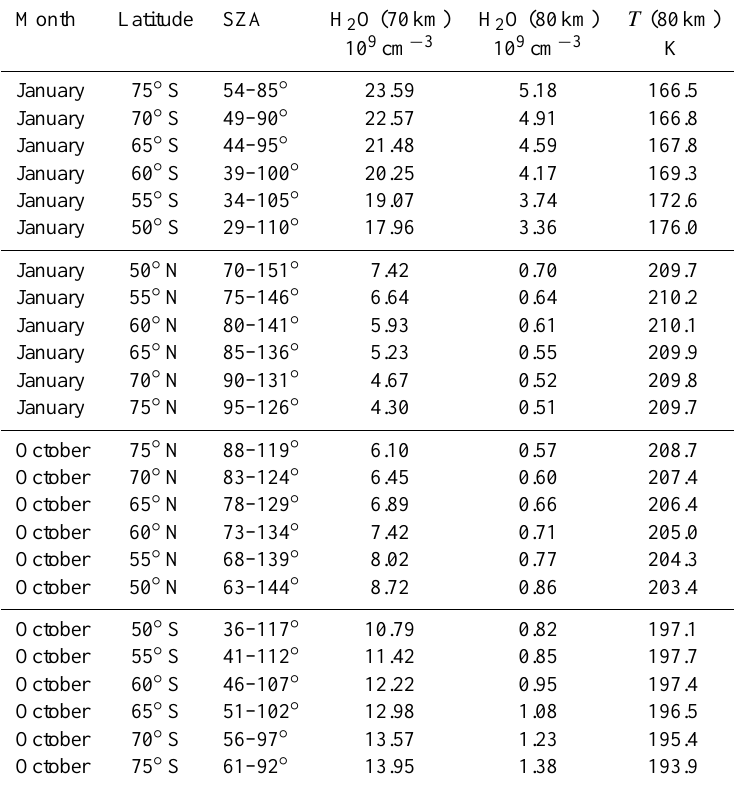
Table 2. List of model runs. Solar zenith angles (SZAs) give the range between noon and midnight. H 2 O and T values are averages of MLS/Aura observations that were used as input to the